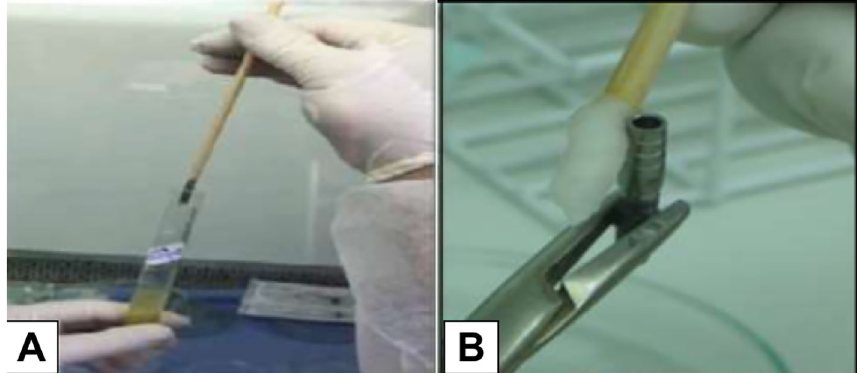
Figure 5. ( A ) The removal of the syringe from the test tube using a thin swab; ( B ) Cleaning of the external surface of the implant-abutment set with a chlorhexidine solution at 0.12%.